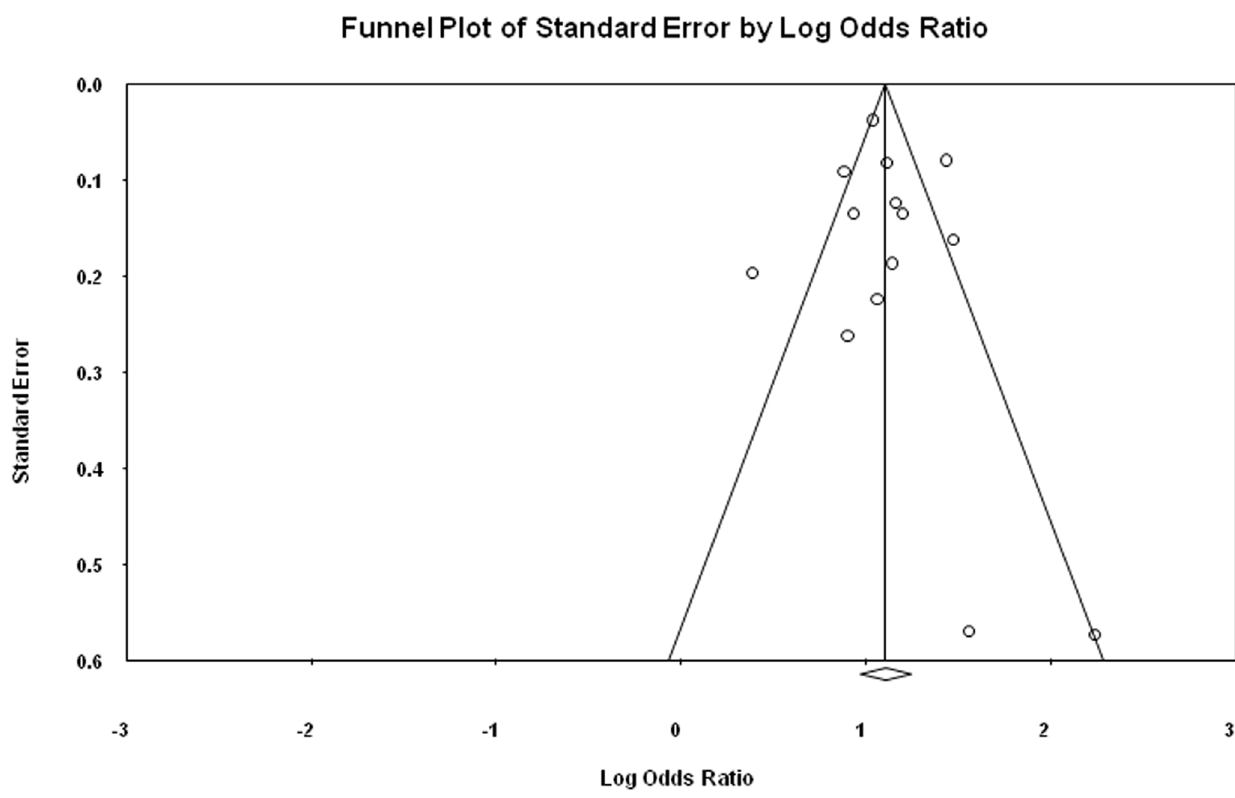
Figure 5. Publication bias for case-control studies illustrating the relationship between ST NOS and incidence of oral cancer.